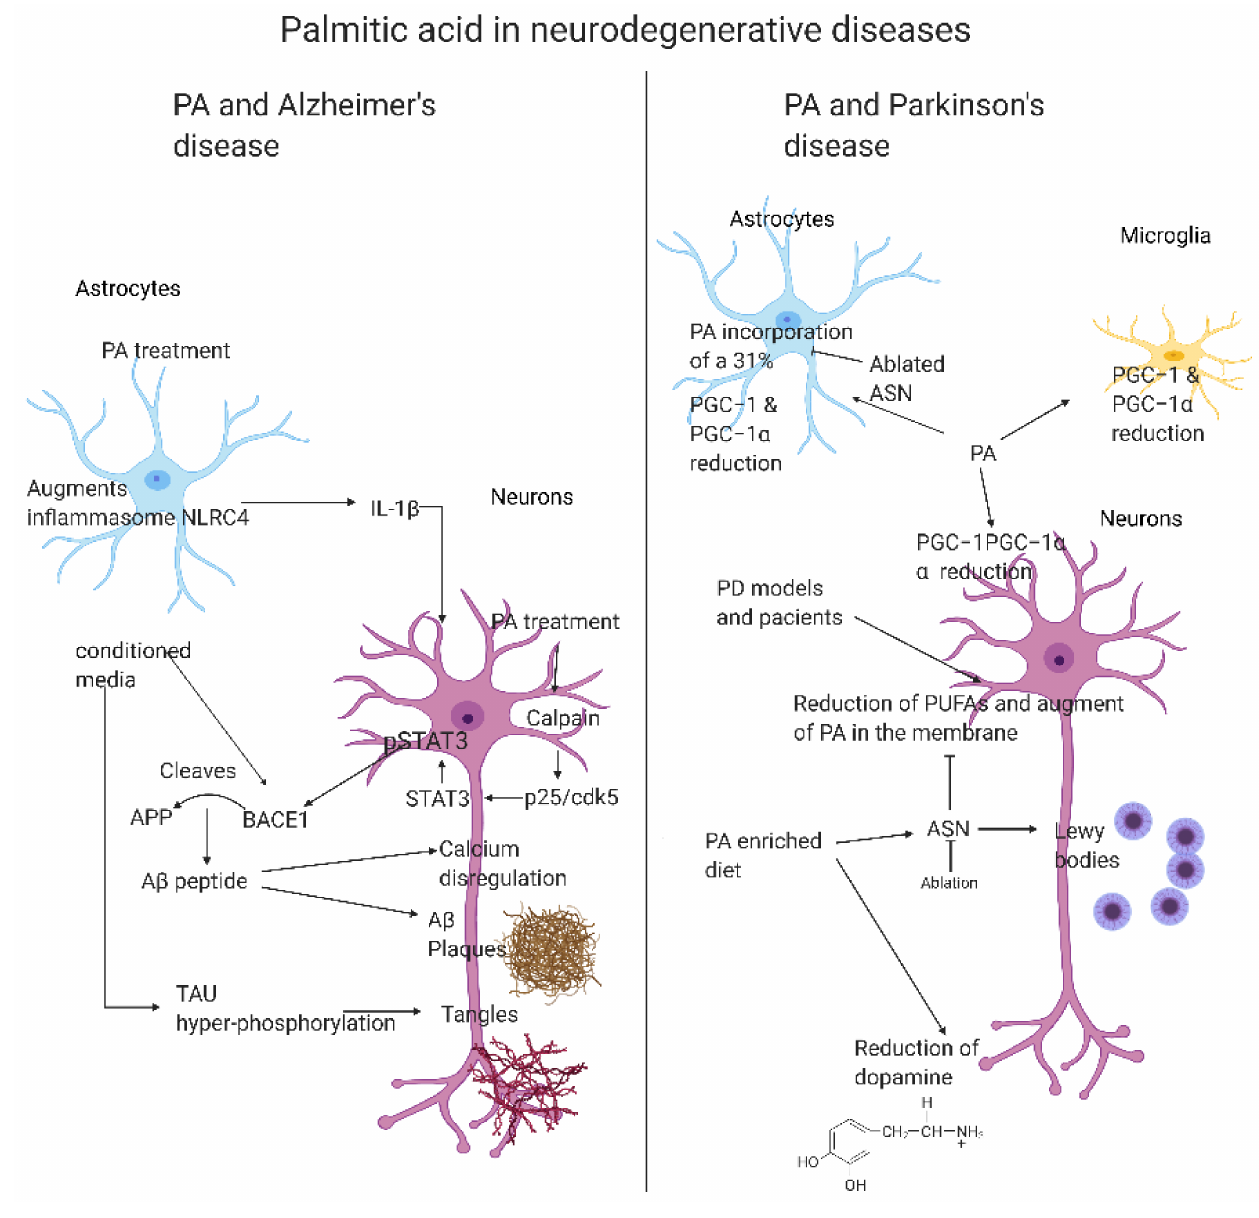
Figure 3. PA in neurodegenerative diseases. This figure shows the reported changes in brain cells induced by PA that are directly linked with the progression of Alzheimer’s and Parkinson’s diseases, as explained in Section 5. This figure shows how the relationship of astrocytes and microglia treated with PA will unleash a pro-inflammatory response that can induce the formation of hallmarks of AD, such as A β tangles and tau hyperphosphorylation, and of PD, causing the appearance of Lewy bodies, a reduction of dopamine, and ASN accumulation. Created with